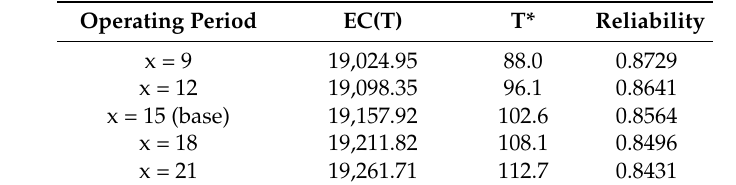
Table 9. Optimal release time with expected total cost EC(T) and the software reliability subject to the operating period.